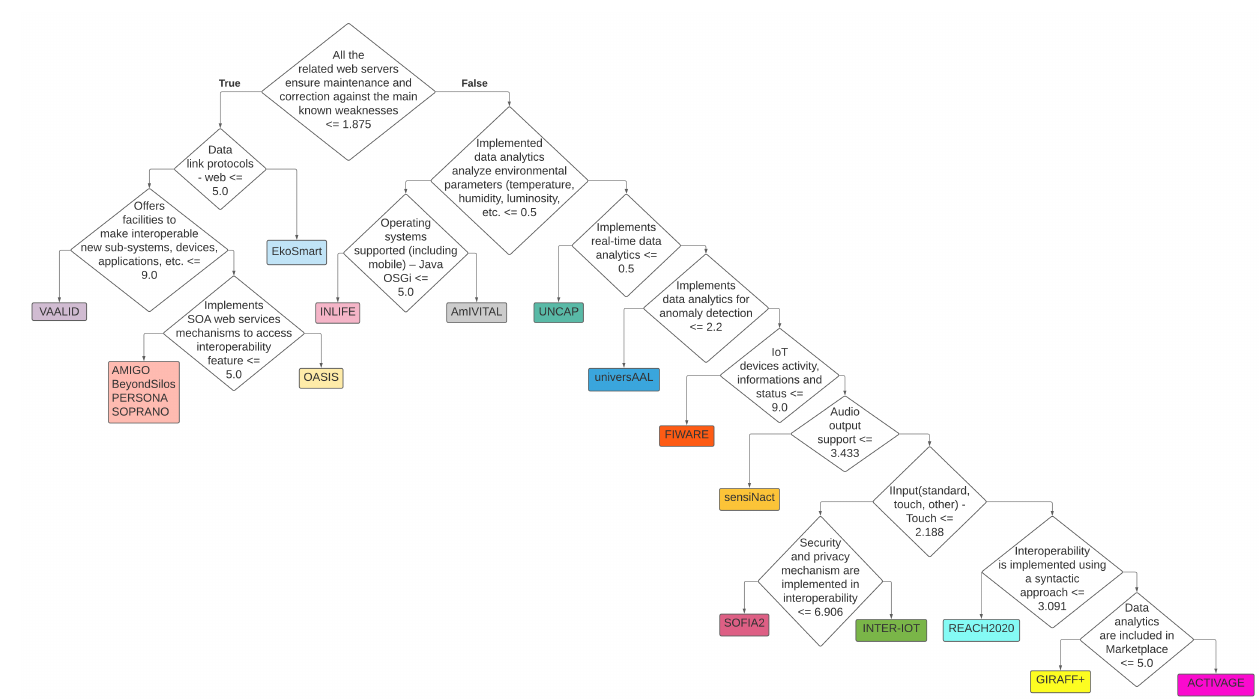
Figure A3. Taxonomy generated from non-standardized input